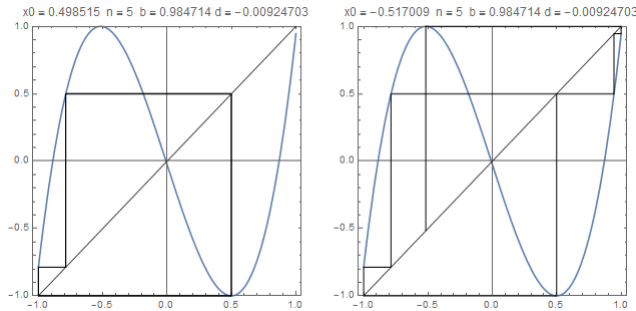
Figure 5. The graphics of f b , d with the trajectories of the critical points, c − and c + in the case b = 0.984713955503324, d = − 0.00924702872344659. the kneading invariant is The growth number is s = 1 +